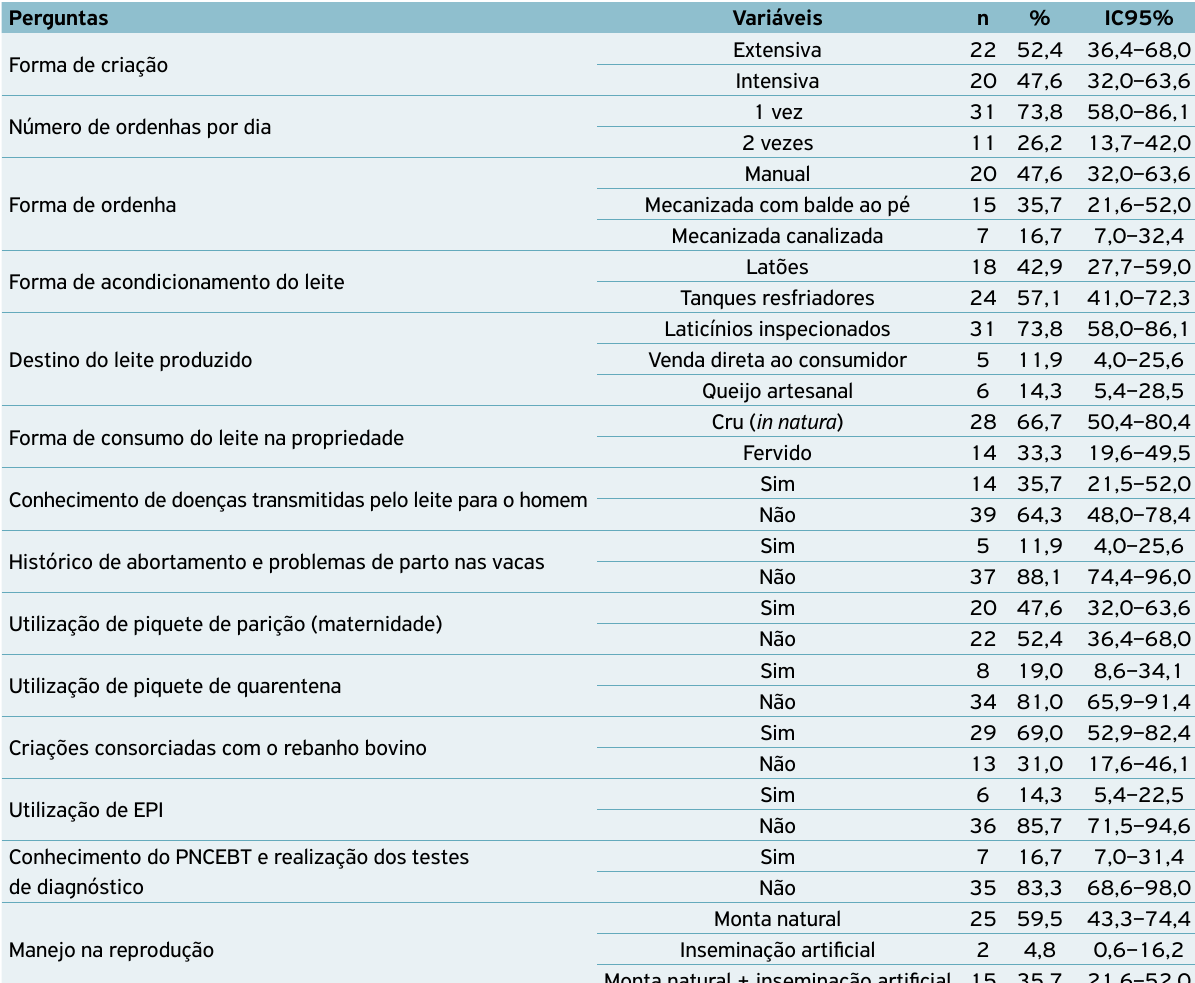
Sul.750 Figura 1. Localização das propriedades amostradas do município de Paranaíba, Mato Grosso do Tabela 1. Variáveis avaliadas por questionário aplicado aos produtores de leite do município de Paranaíba, Mato Grosso do Sul, Brasil, e seus respectivos